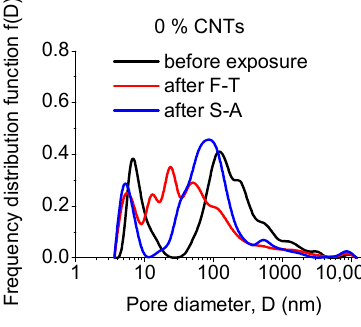
Figure 4. Effect of exposure state on the pore size distribution of un-modified mortars.